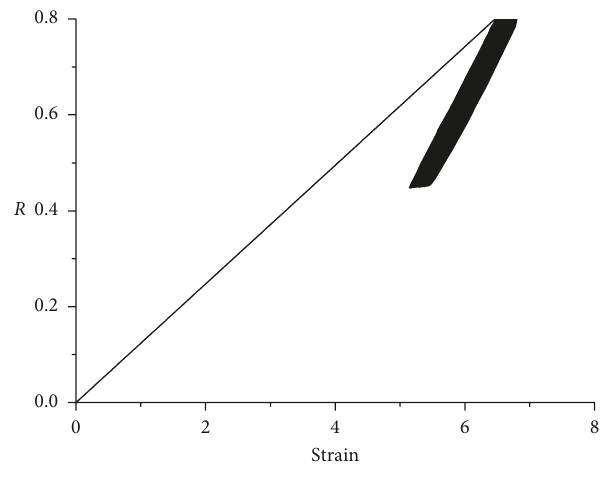
Figure 7: Variation of R with strain